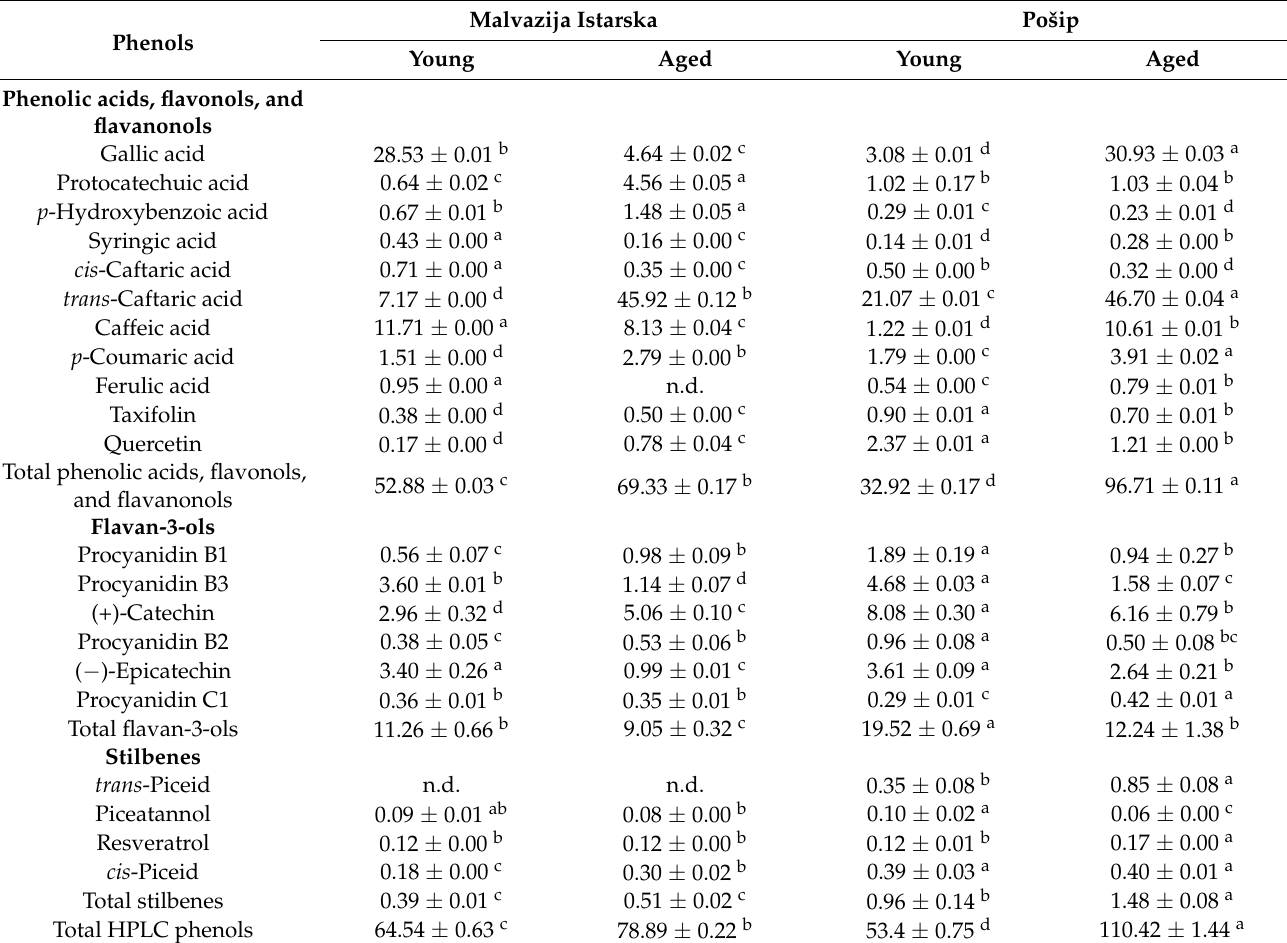
Table 3. Concentrations of HPLC individual phenols (mg/L) of young and aged Malvazija istarska and Pošip